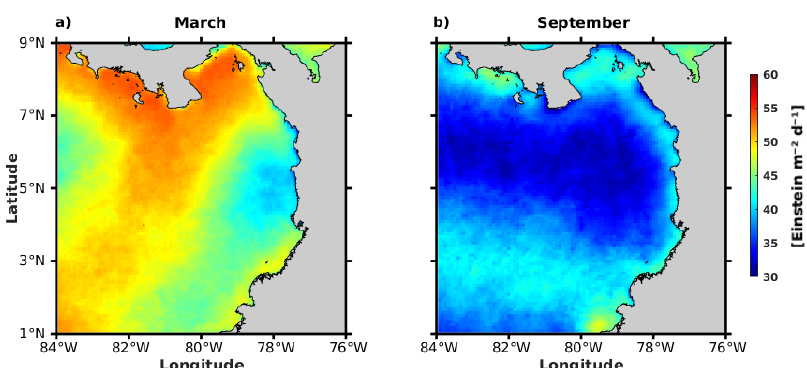
Figure 7. Climatology (2002–2016) of the photosynthetically available radiation (in color scale) for ( a ) March and ( b ) September. Red (blue) shading represents regions with high (low) photosynthetically available radiation.